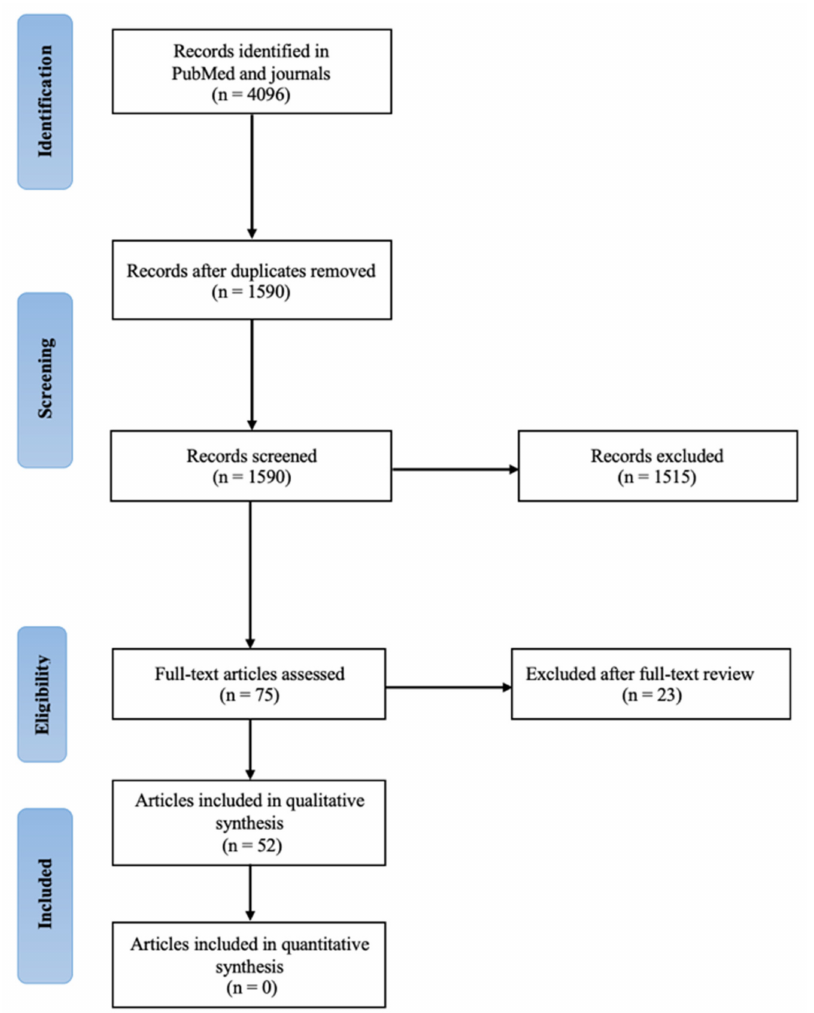
Figure 1. Summary of the search